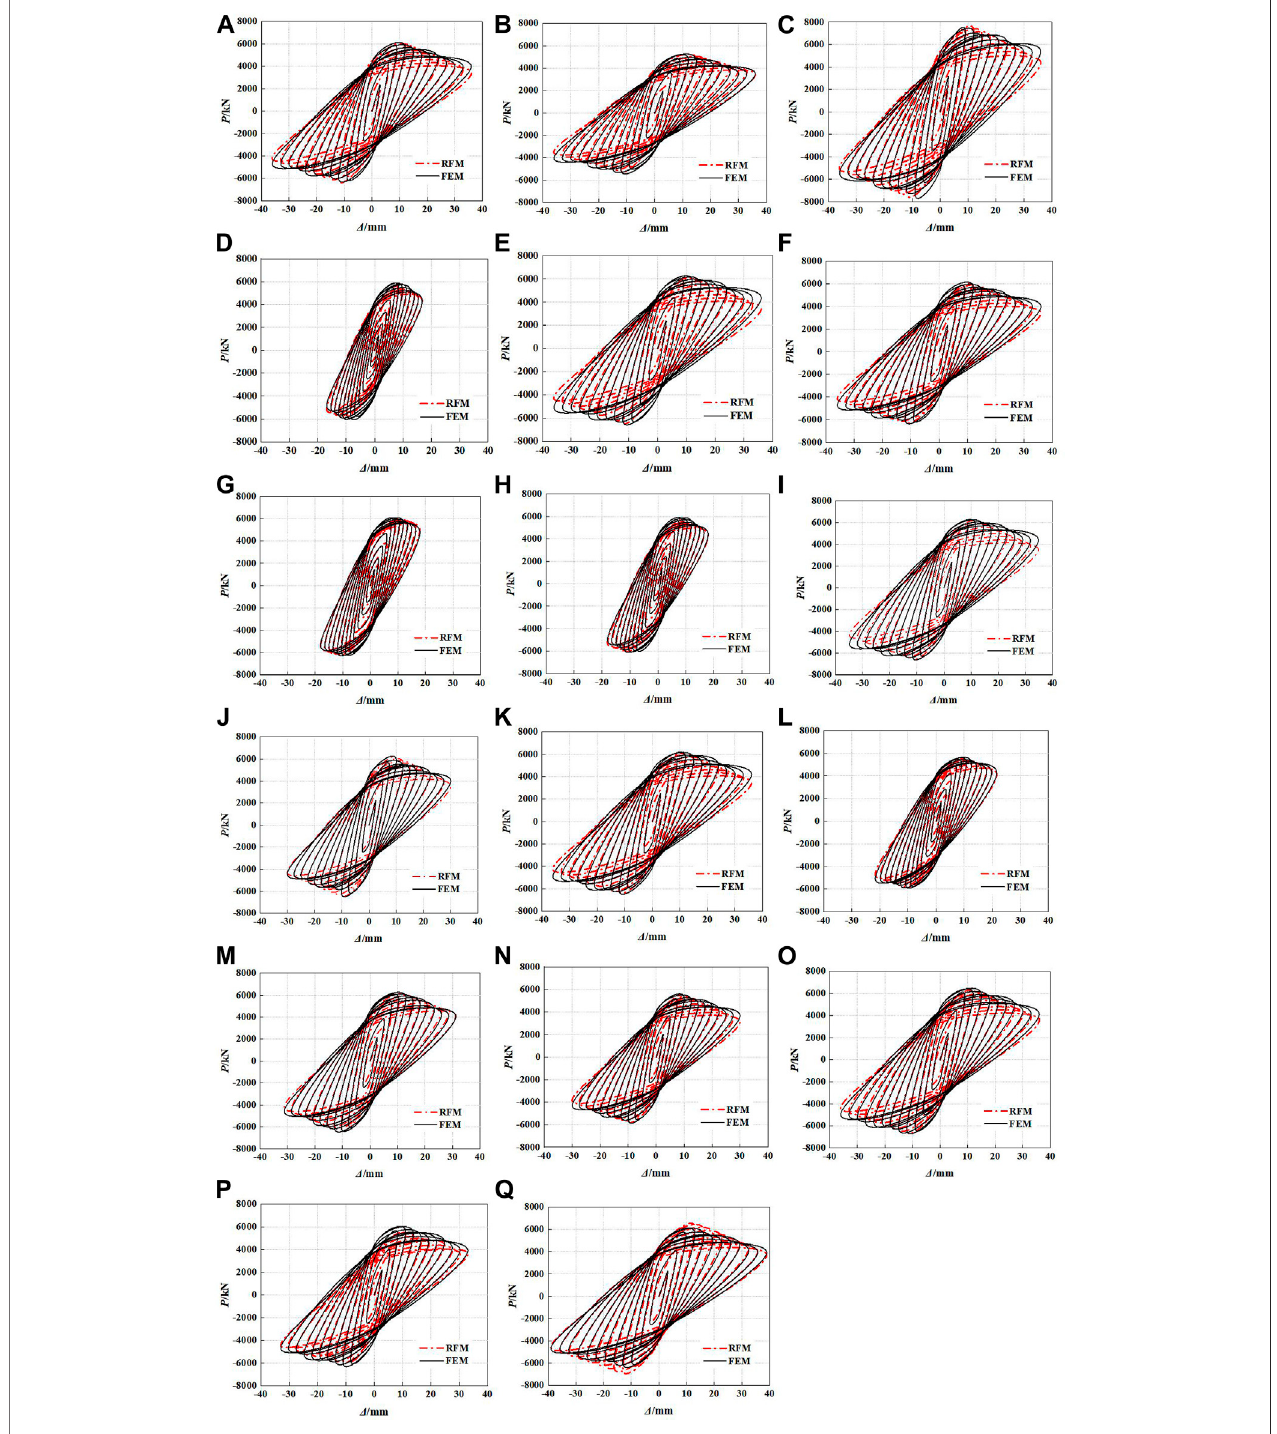
FIGURE 15 | Comparisons of hysteretic curves between RFM and FEM: (A) GRS-1; (B) GRS-2; (C) GRS-3; (D) GRS-4; (E) GRS-5; (F) GRS-6; (G) GRS-7; (H) GRS-8; (I) GRS-9; (J) GRS-10; (K) GRS-11; (L) GRS-12; (M) GRS-13; (N) GRS-14; (O) GRS-15; (P) GRS-16; and (Q) GRS-17.